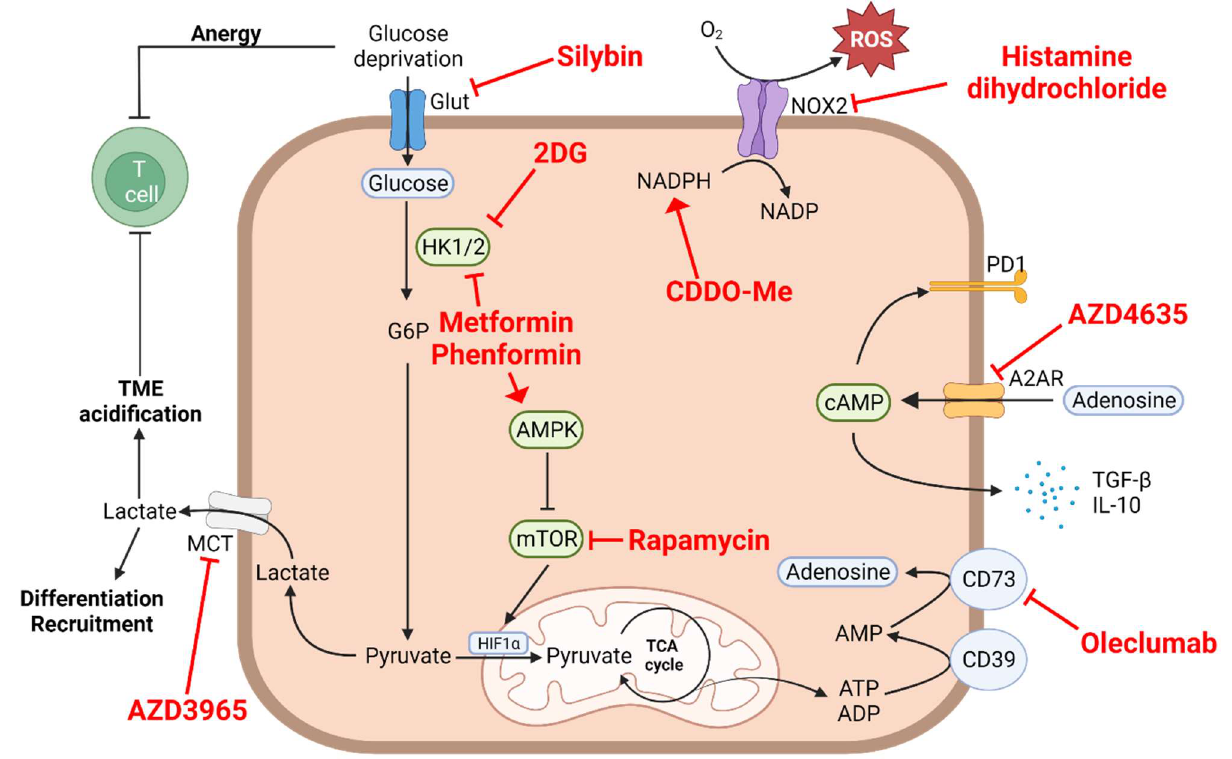
Figure 1. Myeloid cell intrinsic metabolism. Clinical targeting of a specific metabolic pathway regulating immunosuppressive myeloid cell functions is very likely to impact other metabolic pathways essential for their protumoral activity. Drugs currently used in clinical trials targeting different metabolic pathways are depicted in this figure in red. 2DG, 2-deoxyglucose; A2AR, adenosine A2A receptor; ADP, adenosine diphosphate; AMP, adenosine monophosphate; AMPK, 5’ adenosine monophosphate-activated protein kinase; ATP, adenosine triphosphate ATRA, all-trans retinoic acid; cAMP, cyclic adenosine monophosphate; CDDO-Me, bardoxolone methyl; G6P, glucose-6-phosphate; Glut, glucose transporter; HIF1α, hypoxia-inducible factor 1-alpha; HK1/2, hexokinase 1/2; IL-10, interleukin 10; MCT, monocarboxylate transporter; NOX2, NADPH oxidase 2; O 2 , dioxygen; PD1, programmed cell death protein 1; ROS, reactive oxygen species; TCA, tricarboxylic cycle; TGF-β, transforming growth factor β; TME, tumor microenvironment.